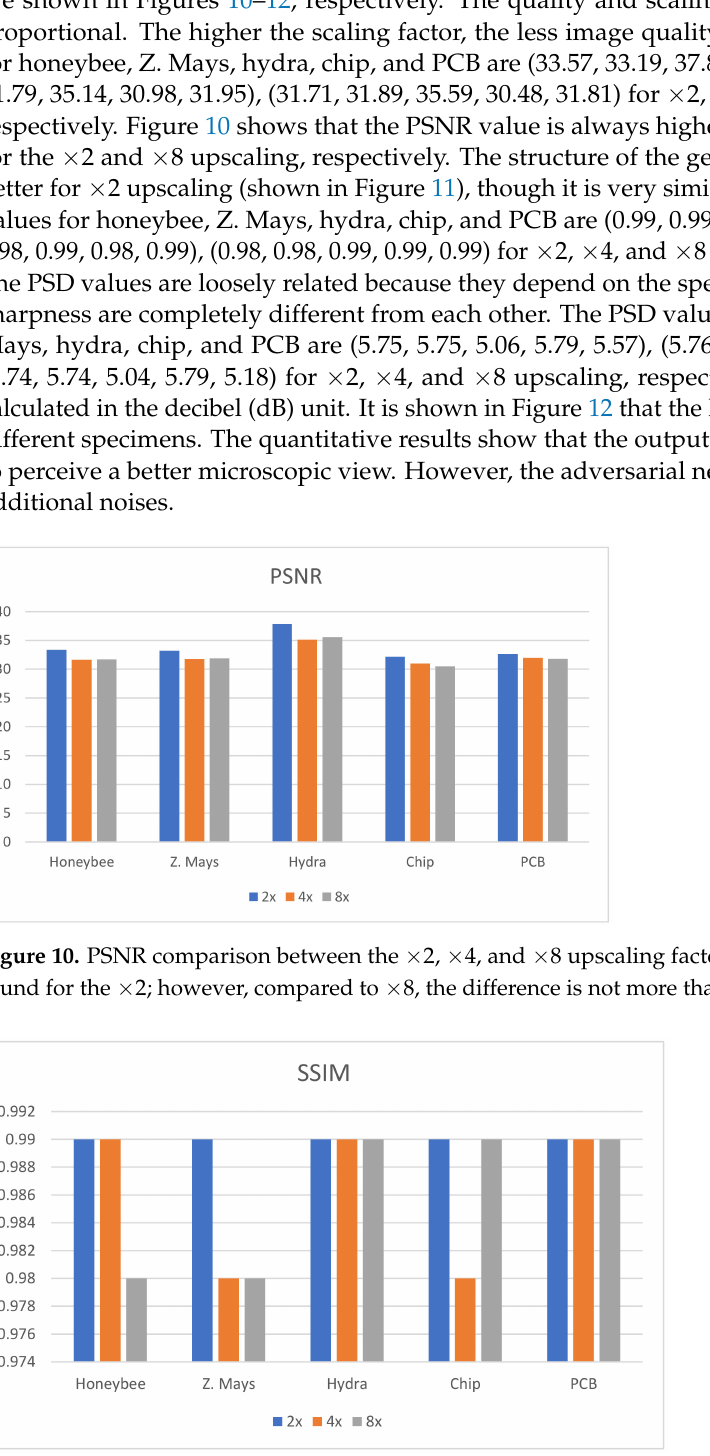
Figure 11. SSIM comparison between the × 2, × 4, and × 8 upscaling factors. The best result is found for × 2 upscaling, which means the output and original image is more